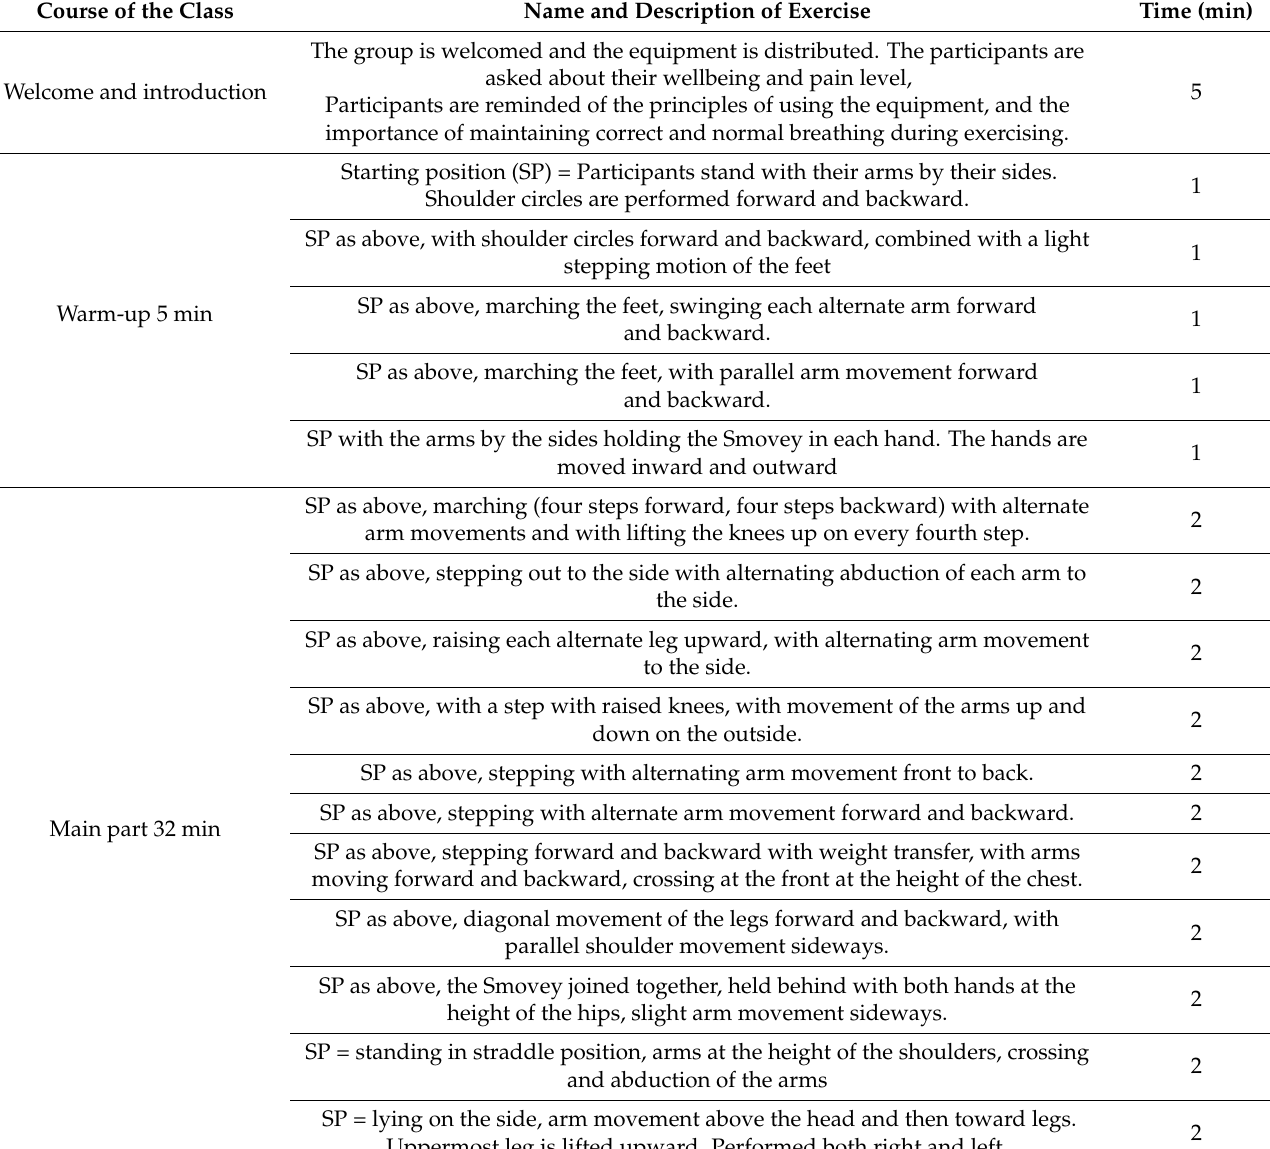
Table A2. Overview of the exercise